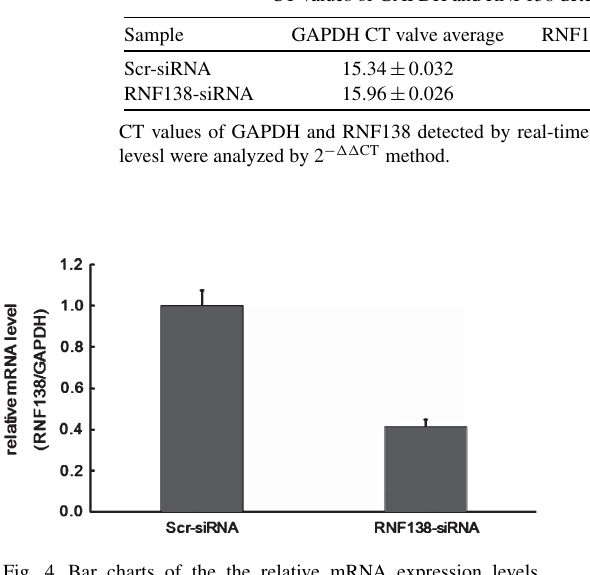
Fig. 4. Bar charts of the the relative mRNA expression levels between the RNF138-RNAi-Lentivirus (KD) and negative control Lentivirus (NC). The RNF138 mRNA level decreased significantly by knocking down